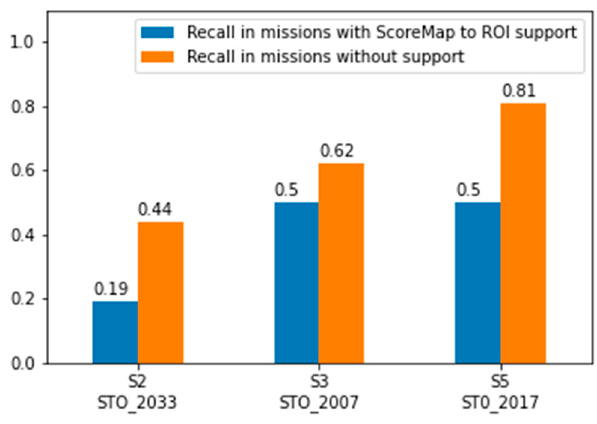
Figure 19. Comparison of the most difficult examples (the least detected persons) in missions (mission Stolac 2) with the ScoreMap to ROI support and the same examples in missions without support.